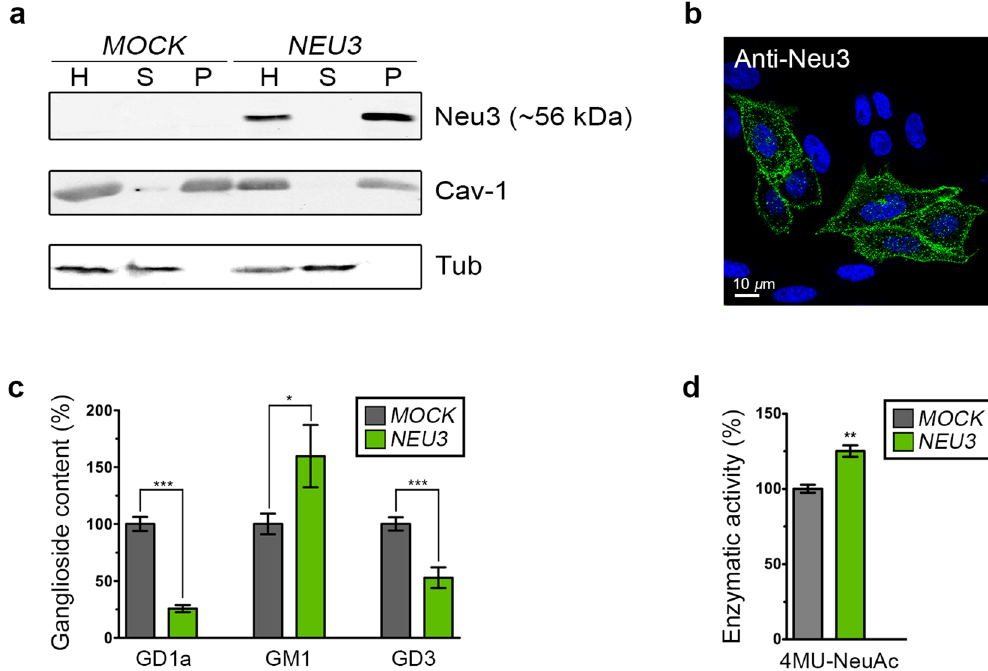
Figure 1. Expression of human sialidase Neu3 in CHO-K1 cells. ( a ) MOCK - and NEU3 -transfected cells were mechanically lysed, and the homogenates (H) were ultracentrifuged. Neu3 expression in both supernatant (S) and pellet (P) fractions was determined by Western blotting using anti-Neu3 antibody. Caveolin-1 (Cav-1) and tubulin (Tub) were used as endogenous markers of a membrane-bound and a soluble protein, respectively. ( b ) Fixed and permeabilized NEU3 -transfected cells were immunostained with antibody against Neu3 and visualized by confocal microscopy. Cells nuclei were stained blue with Hoechst dye. ( c ) Ganglioside content of MOCK - and NEU3 -transfected cells. Cells were incubated with antibody against GD3, antibody against GD1a or CTx β (which binds to GM1) at 4 °C for 60 min to label the plasma membrane-associated gangliosides. Then, cells were fixed, permeabilized, incubated with antibody against Neu3 and visualized by confocal microscopy. Ganglioside content was quantified according to its fluorescence intensity using ImageJ software. Values are related to the percentage of each ganglioside in MOCK -transfected cells and presented as mean ± S.E.M. Statistical analyses were made using Student’s t test with significance being attributed at the 95% level of confidence ( * P ≤ 0.05; ** P ≤ 0,01; *** P ≤ 0,001). ( d ) Total sialidase activity in cell homogenates of MOCK - and NEU3 -transfected cells towards the artificial substrate